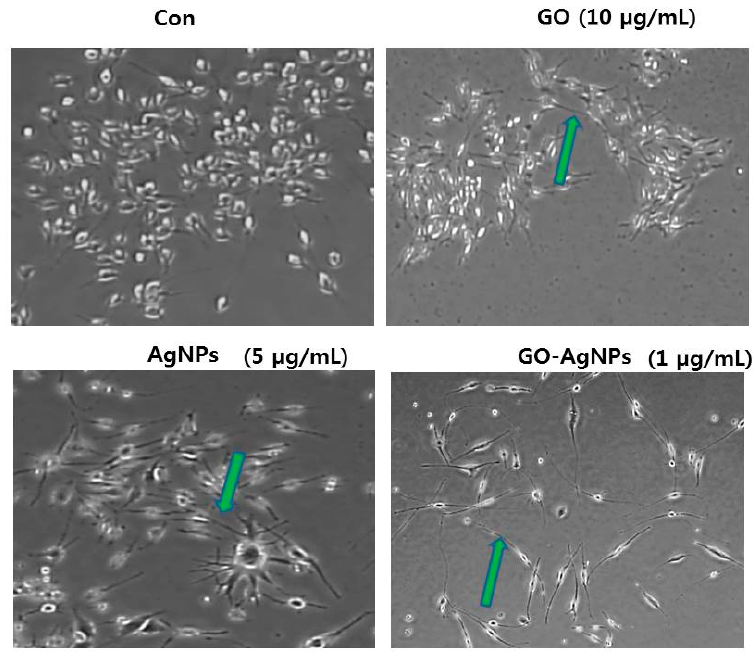
Figure 4. The effect of GO-AgNPs treatment on differentiation of SH-SY5Y cells. The GO-AgNPs induced differentiation of SH-SY5Y cells was determined after 24-h exposure to GO (10 µg/mL), AgNPs (5 µg/mL) and GO-AgNPs (1.0 µg/mL). Phase contrast microscopy images showing the morphological changes in SH-SY5Y cells after treatment with GO-AgNPs in 1% serum-supplemented medium. The green arrows indicate significant, lengthy neurite outgrowth. At least three independent experiments were performed for each sample. Scale bar is 100 µm.